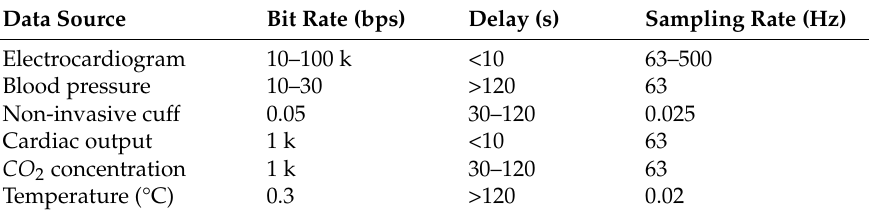
Table 2. Delay and bit rate requirements of healthcare data